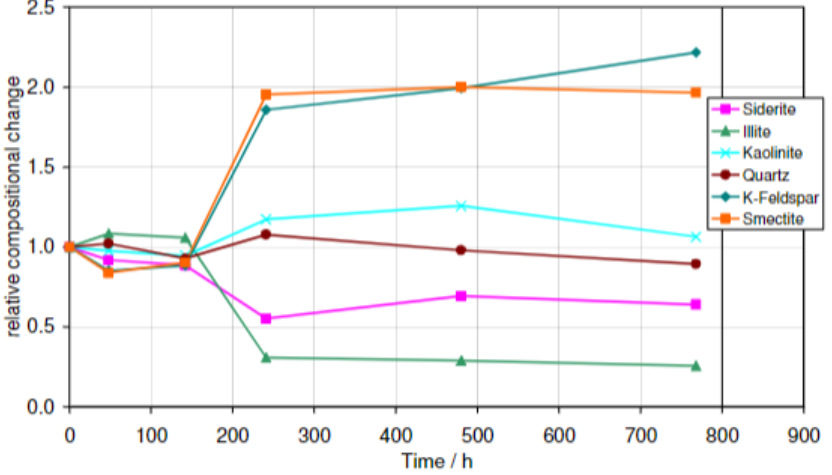
Figure 6. Mineralogical changes over time for Muderong shale when exposed to wet CO 2 . Reprinted from [58]. Copyright (2009), with permission from Elsevier.